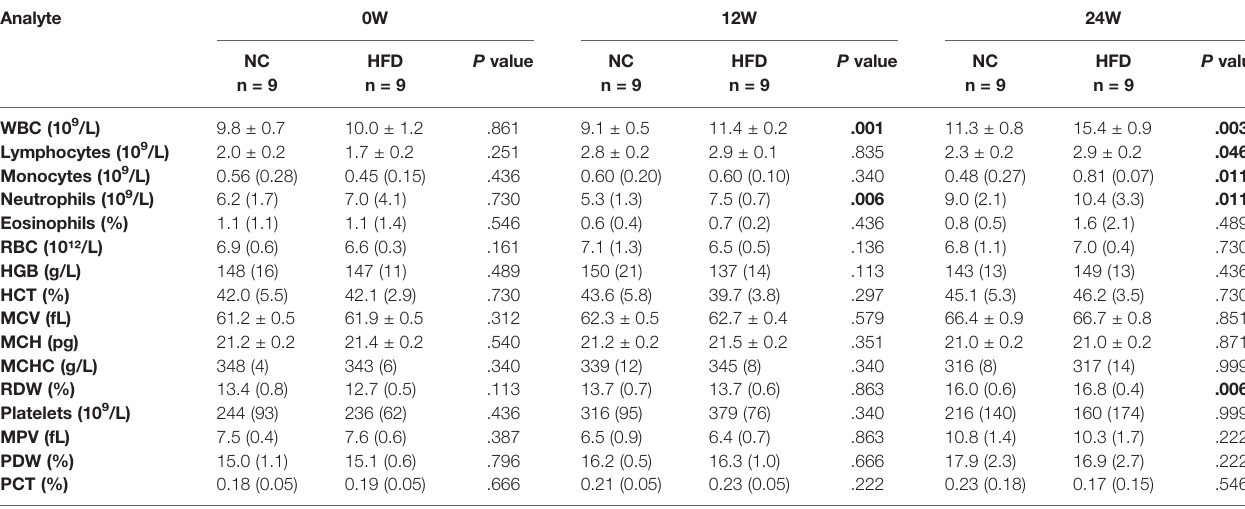
TABLE 2 | Blood Routine Examination of NC and HFD-fed Dogs.